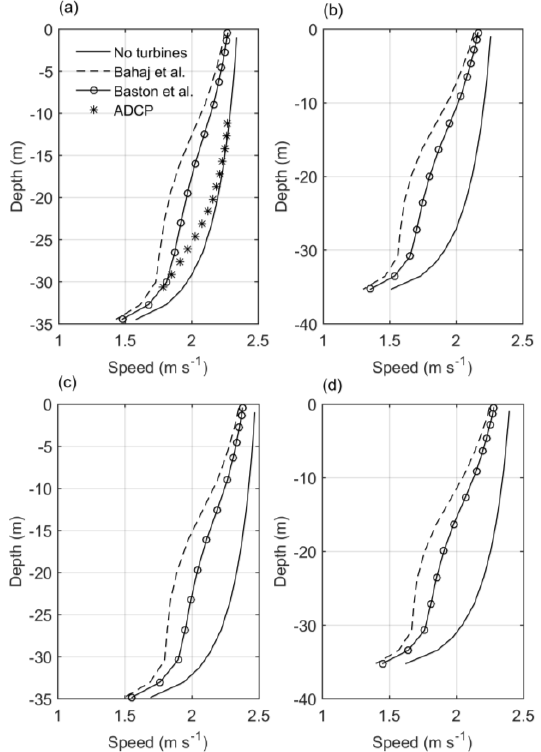
Figure 7. Vertical profiles of mean current speed (m·s −1 ) at the sites of the first four turbines ( a – d ) to be deployed in the Inner Sound without turbines (―) and with turbine parameterisation by Bahaj et al. [35] (- -) and Baston et al. [36] (-o-). Mean speed from the nearby ADCP deployment (*) is shown for comparison.